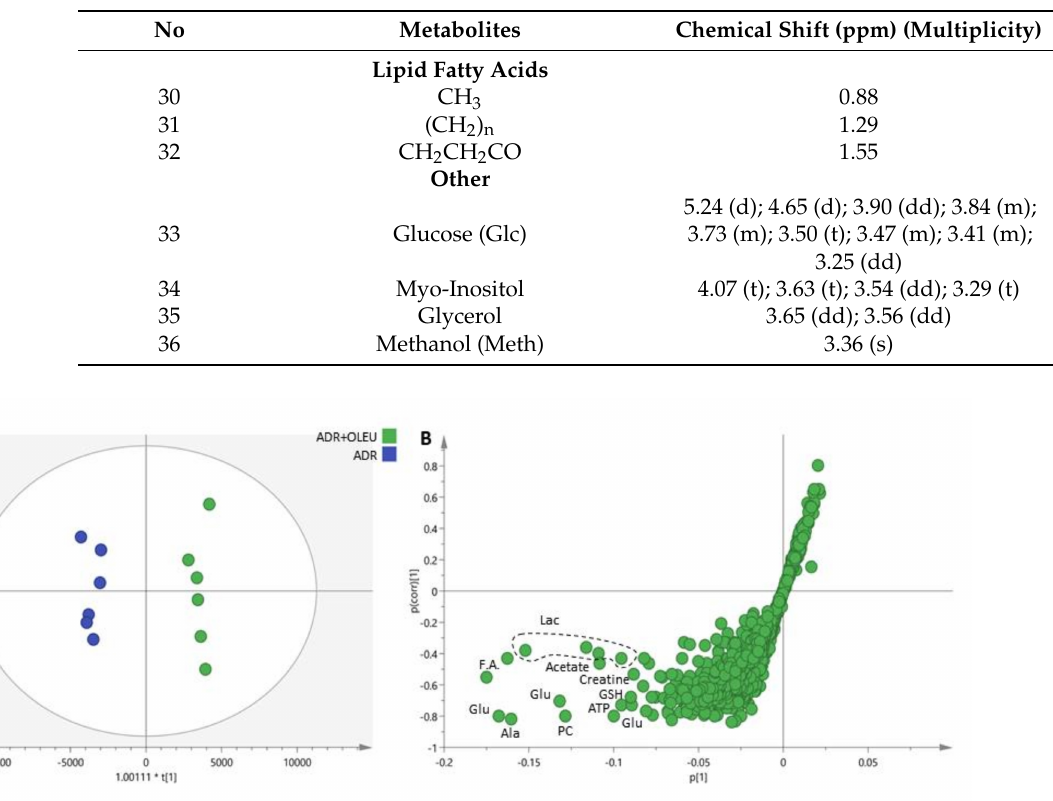
Figure 7. ( A ) OPLS-DA scores plot (R2Xcum = 0.76, Q2cum = 0.31) and ( B ) S-plot of pareto scaled 1 H NMR data of the aqueous extracts of MG-63 cells treated with ADR (50 nM) and with the mixture of ADR (Adriamycin) and OLEU (Oleuropein) (50 nM and 20 µ g/mL, respectively). Glu: Glutamate, Ala: Alanine, PC: O-Phosphocholine, ATP: Adenosine triphosphate, GSH: glutathione, F.A.: Fatty acids, Lac: Lactate; OPLS-DA: Orthogonal Partial Least Squares Discriminant Analysis; R2Xcum: cumulative explained variation; Q2cum: predicted